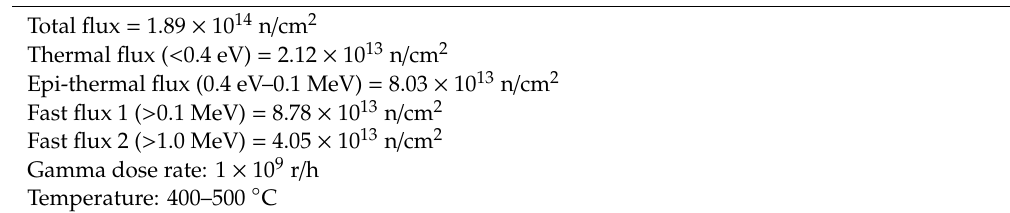
Table 4. MIT research reactor environment.